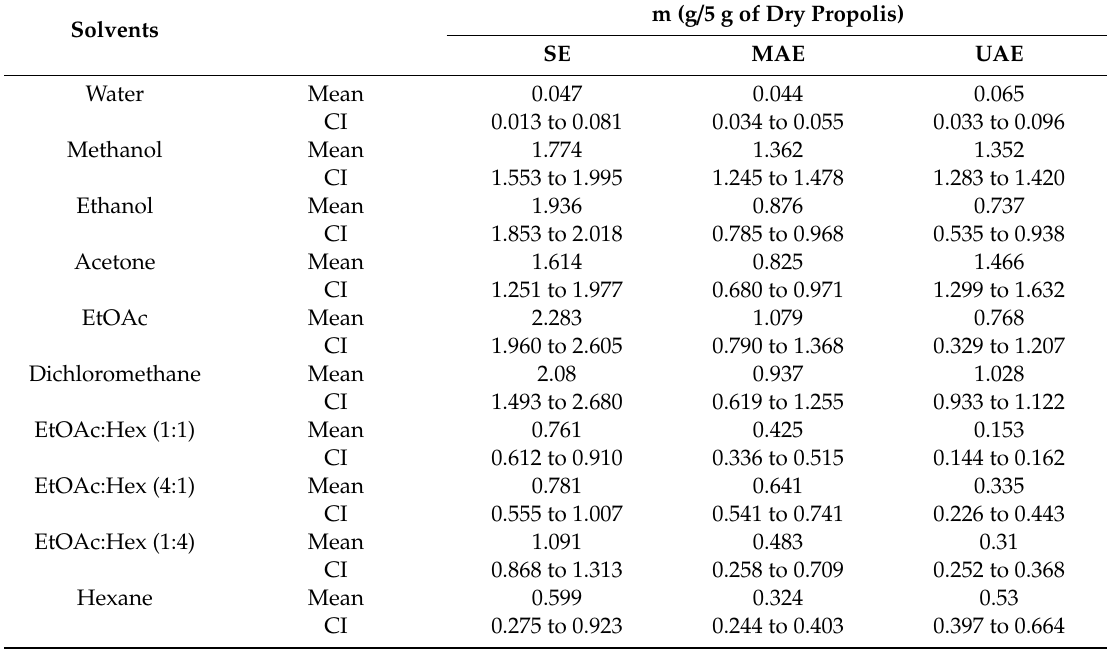
Table 1. Extraction yield of propolis with di ff erent extraction methods and